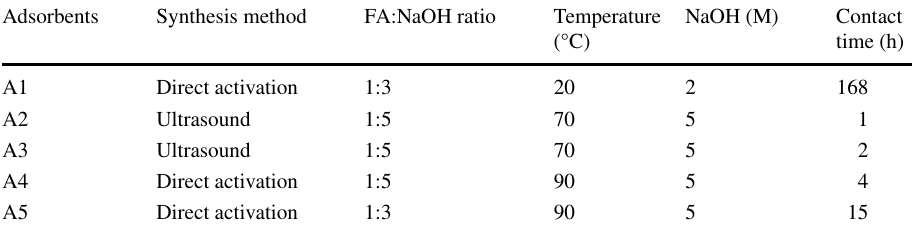
conditions of adsorbent